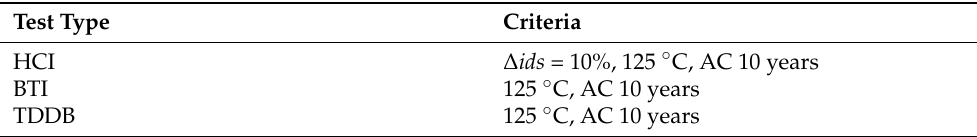
Table 3. Detailed criteria for reliability test from